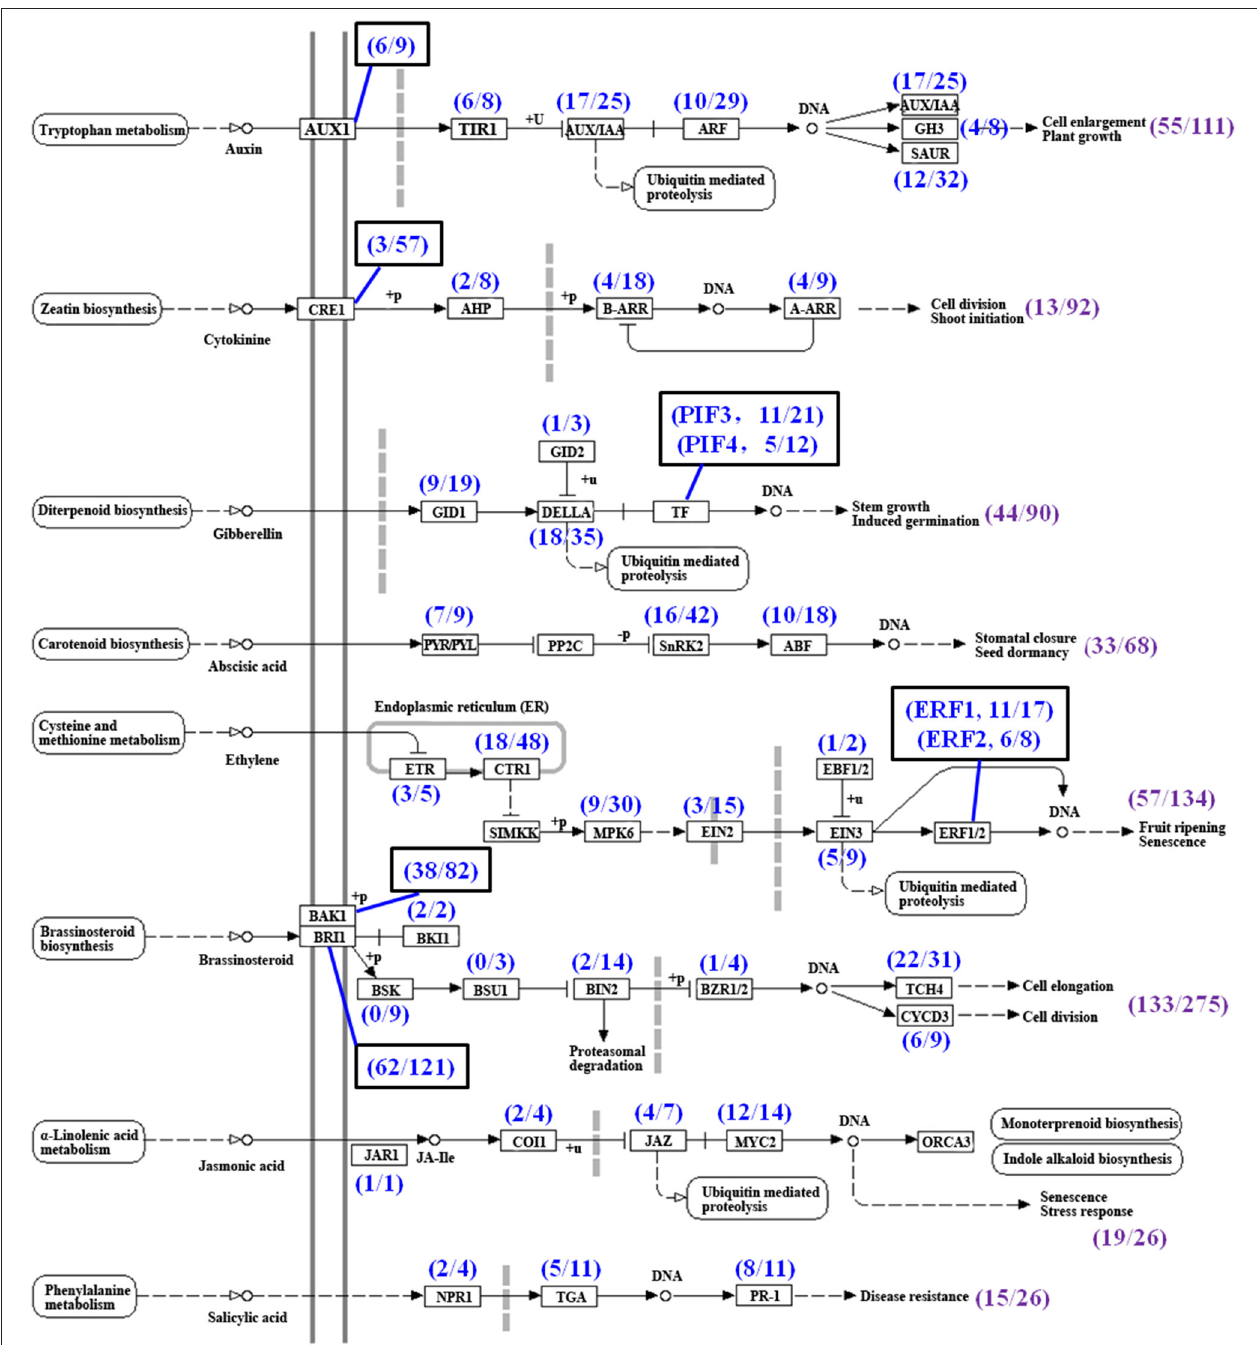
FIGURE 9 | Summary of unigenes in phytohormone signal transduction pathways (referring to the KEGG pathway map04075) in T. hemsleyanum FD-TRs. AUX1, auxin influx carrier; TIR1, transport inhibitor response 1; AUX/IAA, auxin-responsive protein/indole-3-acetic acid; ARF, auxin response factor; GH3, auxin-responsive GH3 gene family; SAUR, small auxin-up RNA family protein; CRE, Arabidopsis histidine kinase 2/3/4 (cytokinin receptor); AHP, histidine-containing phosphotransfer protein; A-ARR, two-component response regulator A-ARR family; B-ARR, two-component response regulator B-ARR family; GID1, gibberellin receptor GID1; GID2, F-box protein GID2; PIF, phytochrome-interacting factor; PYL/PYL, abscisic acid receptor PYR/PYL family; SnRK2, serine/threonine-protein kinase SRK2; ABF, ABA-responsive element binding factor; ETR, ethylene receptor; CTR1, serine/threonine-protein kinase CTR1; MPK6, mitogen-activated protein kinase 6; EIN2, ethylene-insensitive protein 2; EIN3, ethylene-insensitive protein 3; EBF1/2, EIN3-binding F-box protein; ERF, ethylene-responsive transcription factor; BAK1, brassinosteroid insensitive 1-associated receptor kinase 1; BRI1, protein brassinosteroid insensitive 1; BKI1, BRI1 kinase inhibitor 1; BSK, BR-signaling kinase; BSU1, serine/threonine-protein phosphatase BSU1; BIN2, protein brassinosteroid insensitive 2; BZR1/2, brassinosteroid resistant 1/2; TCH4, xyloglucan:xyloglucosyl transferase TCH4; CYCD3, cyclin D3; JAR1, jasmonic acid-amino synthetase; COI-1, coronatine-insensitive protein 1; JAZ, jasmonate ZIM-domain-containing protein; MYC2, transcription factor MYC2; NPR1, regulatory protein NPR1; TGA, transcription factor TGA; PR-1, pathogenesis-related protein 1, Sp, spring; Su, summer; Au, autumn; Wi, winter.